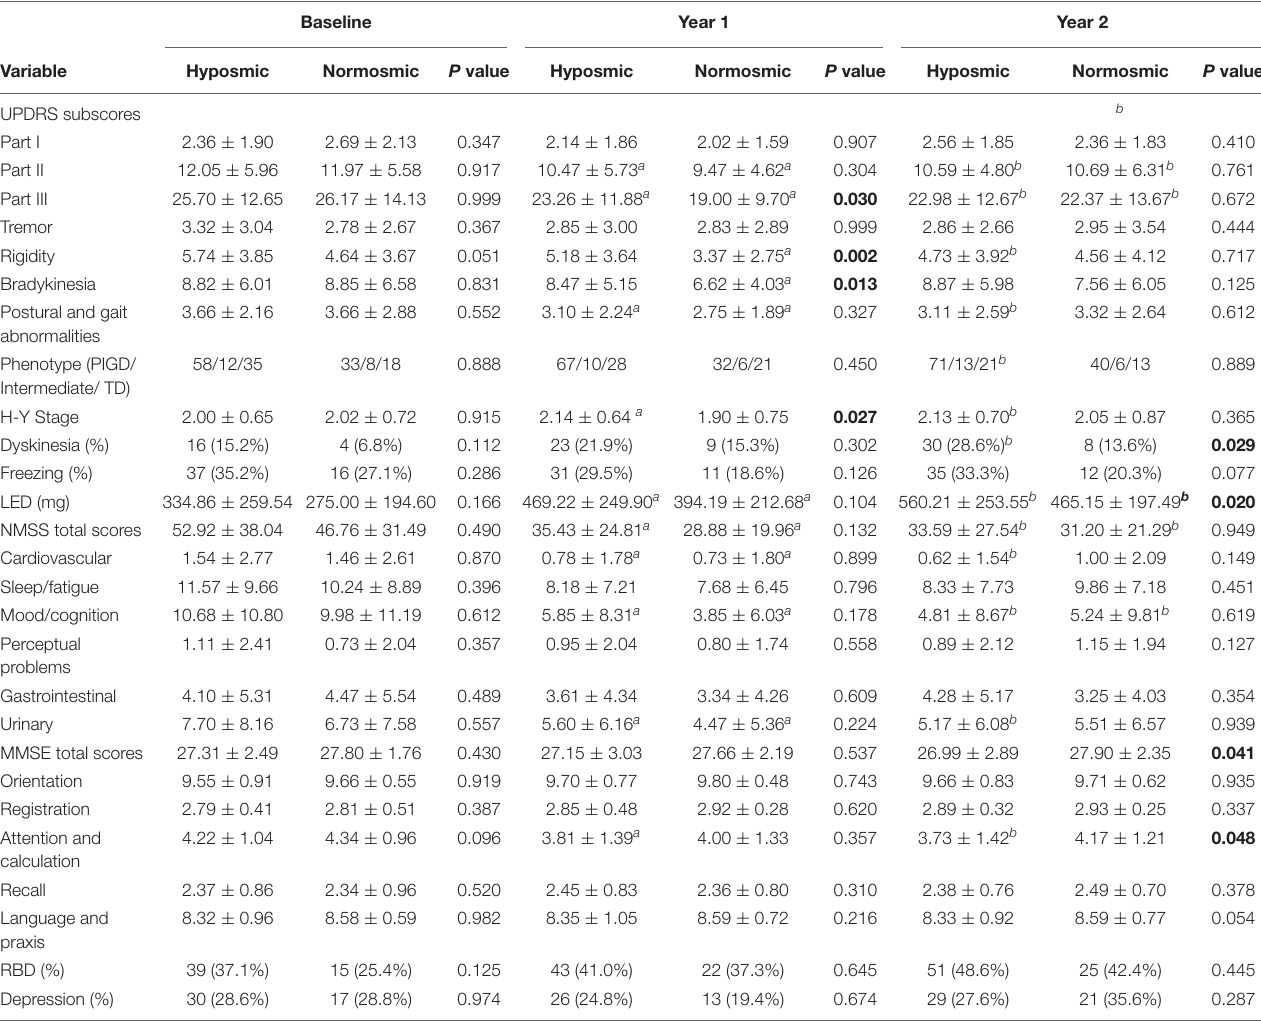
TABLE 2 | PD motor and non-motor characteristics of the hyposmic PD patients and normosmic PD patients over